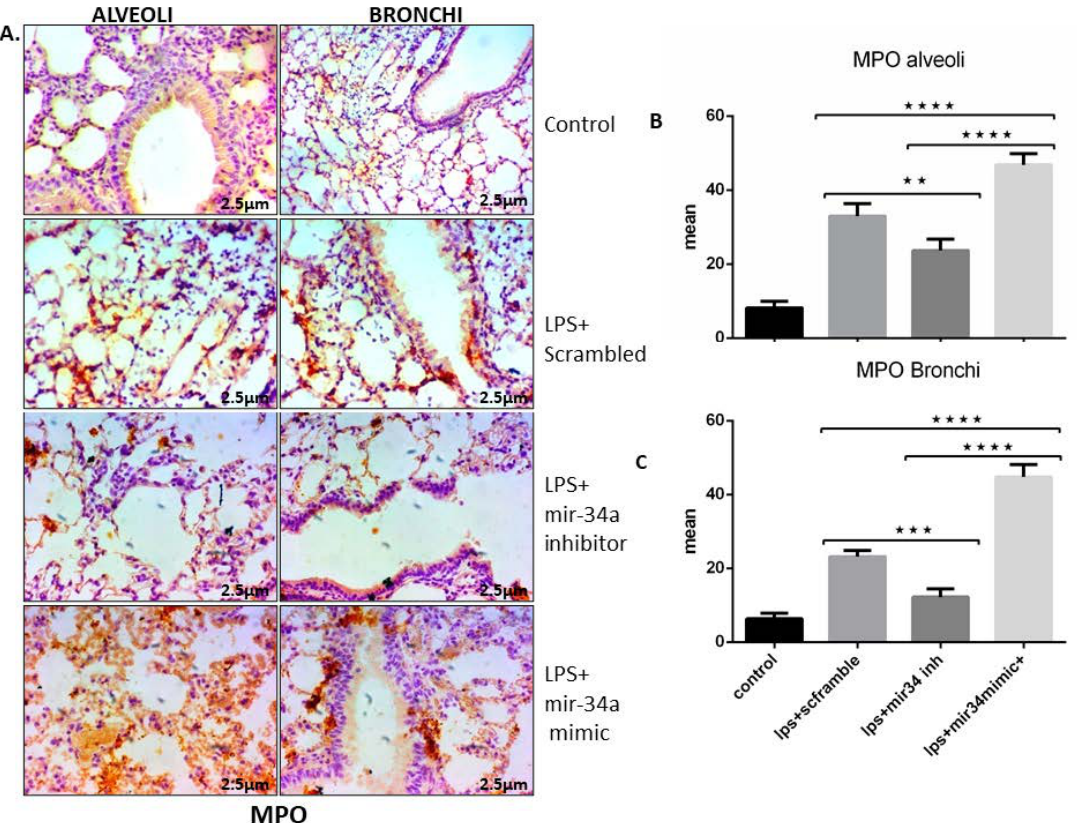
Figure 3. miR-34 inhibition reduced expression of LPS induced myeloperoxidase (MPO) in mice. ( A ) IHC stained representative lung slides shows the expression of MPO in alveolar and bronchial sections of lung tissue in different treatment groups. ( B , C ) expression of MPO quantified and statistically analyzed using two-way ANOVA *** p < 0.001, **** p < 0.0001 ( n = 4).